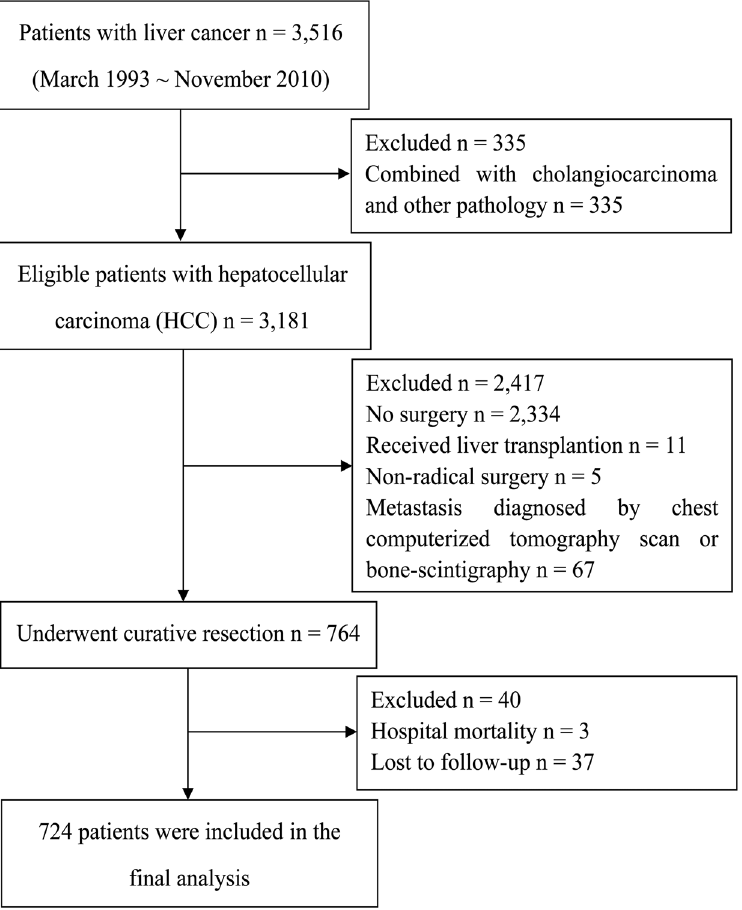
Figure 1. Flow diagram of patients enrolled in this study and reasons for